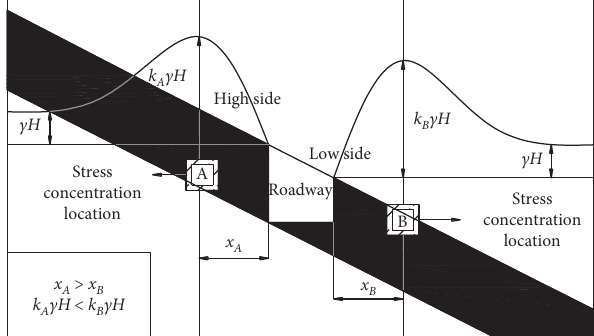
Figure 2: Stress distribution map of the surrounding rock of two